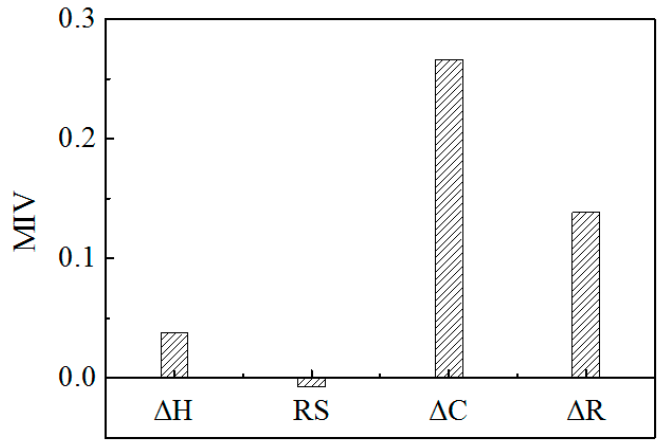
Figure 5. The mean impact values (MIV) for input features ∆ H , RS, ∆ C , and ∆ R .